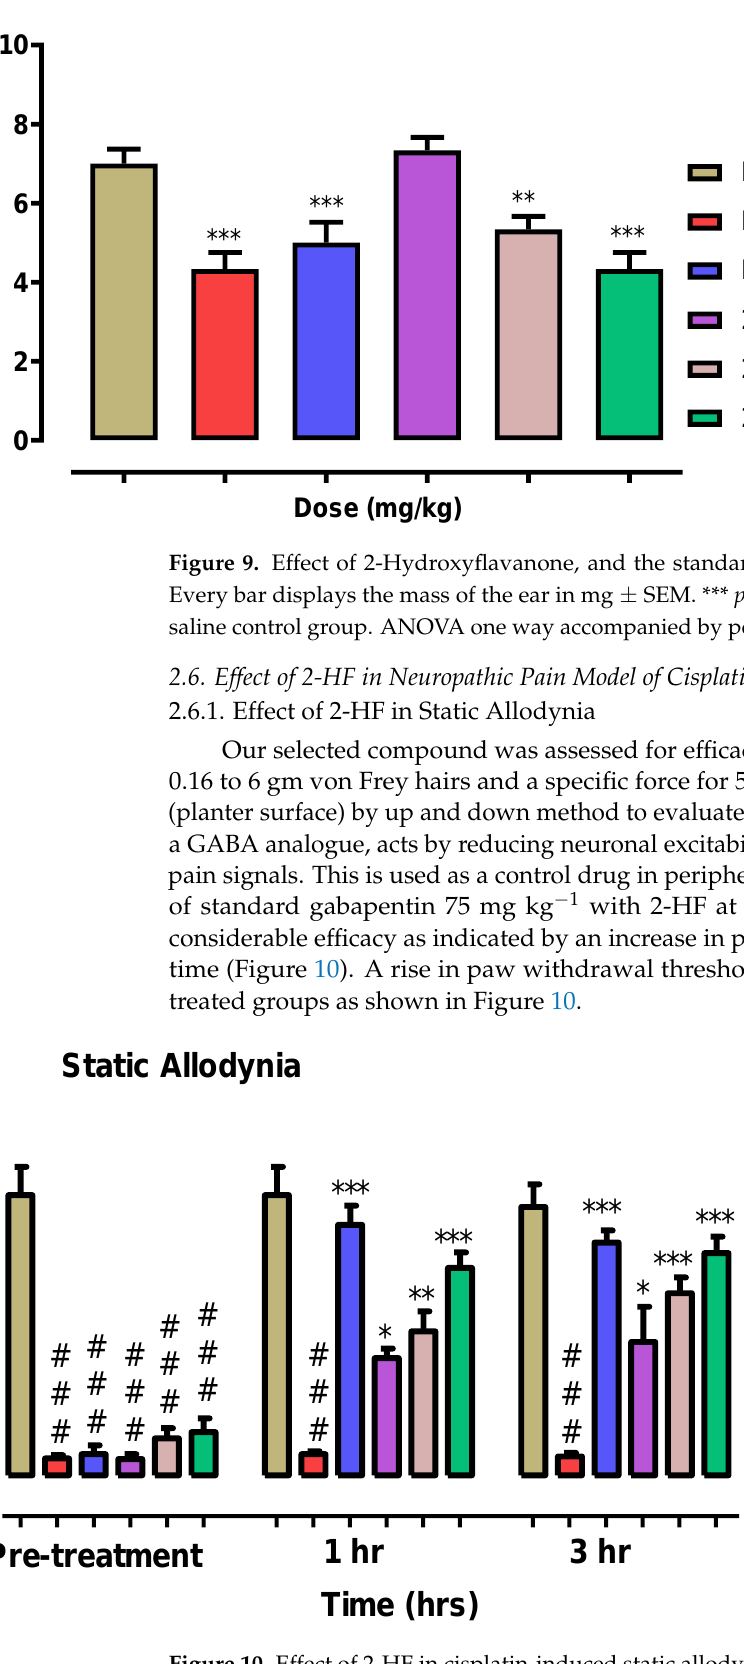
9 of 20 Figure 8. Results of 2-HF, aspirin in the serotonin-mediated paw oedema model. *** p < 0.001, ** p < 0.01, * p < 0.05 versus saline, two- way repeated measures ANOVA followed by Tukey’s post hoc test.